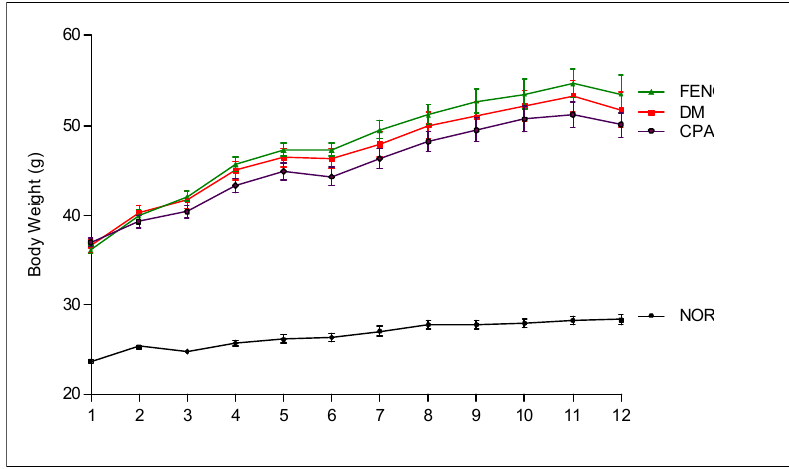
Figure 4. Body weight. NOR, normal control mice; DM, db / db mice; FENO, db / db mice treated with fenofibrate (100 mg / kg); CPA4-1, db / db mice treated with CPA4-1-100 (100 mg / kg). All data are expressed as mean ±